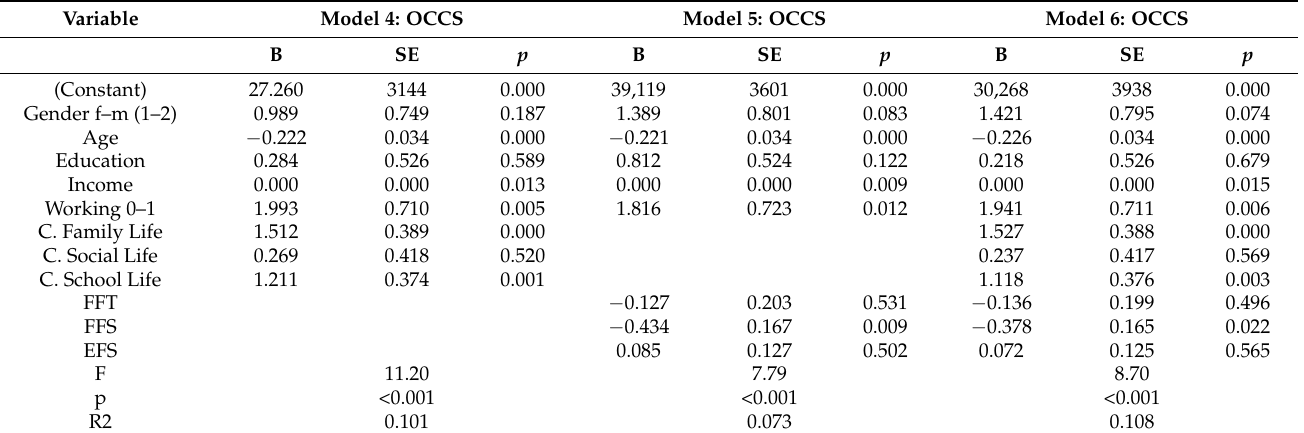
Table 3. Main Effects on Occupational Choice Capability Scale